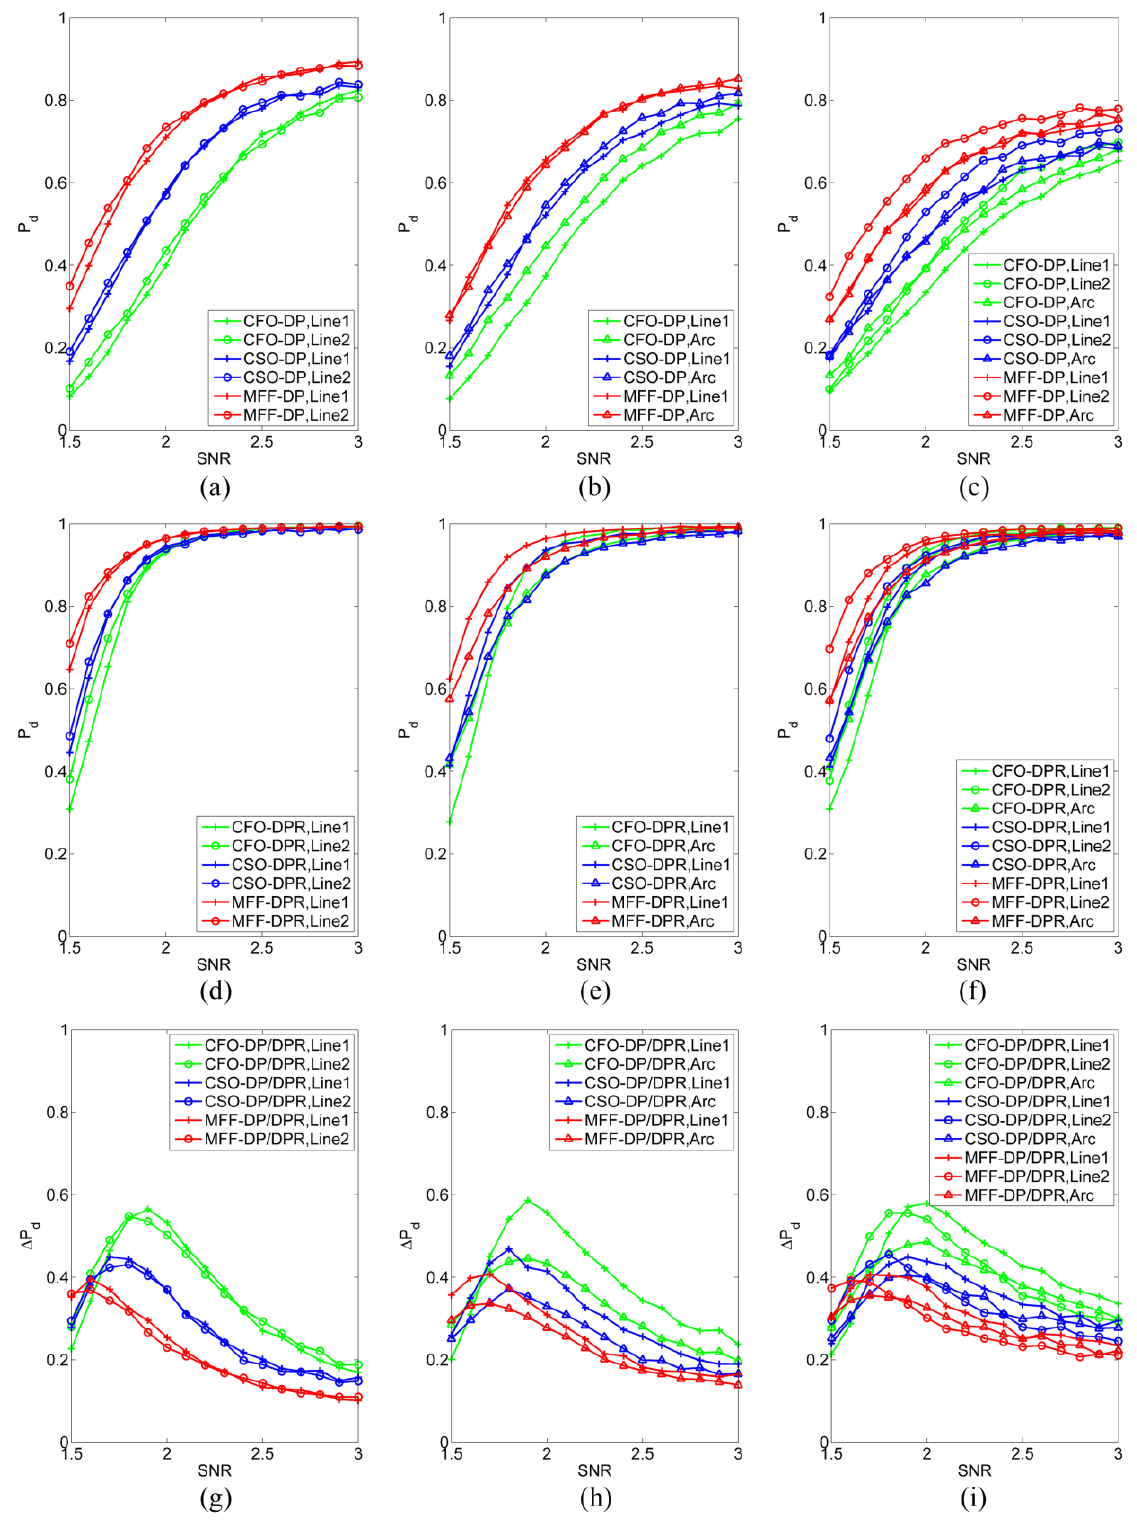
Figure 9. Multi-target detection probabilities of different DP and DPR algorithms. ( a – c ) Detection probabilities of the DP algorithms; ( d – f ) detection probabilities of the DPR algorithms; ( g – i ) differences in detection probabilities between the DPR and DP algorithms; ( a , d , g ) test case 1; ( b , e , h ) test case 2; ( c , f , i ) test case 3.